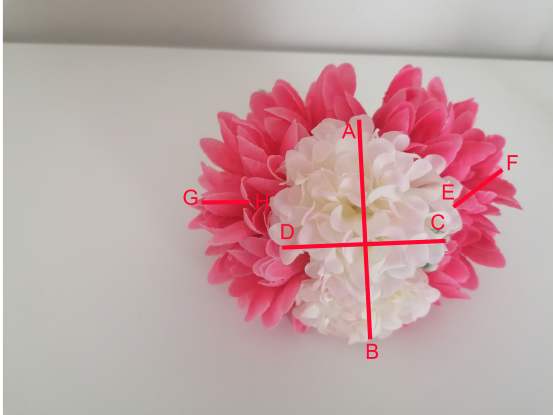
Figure 6 . Distances directly measured on the surface of the “flower” object.